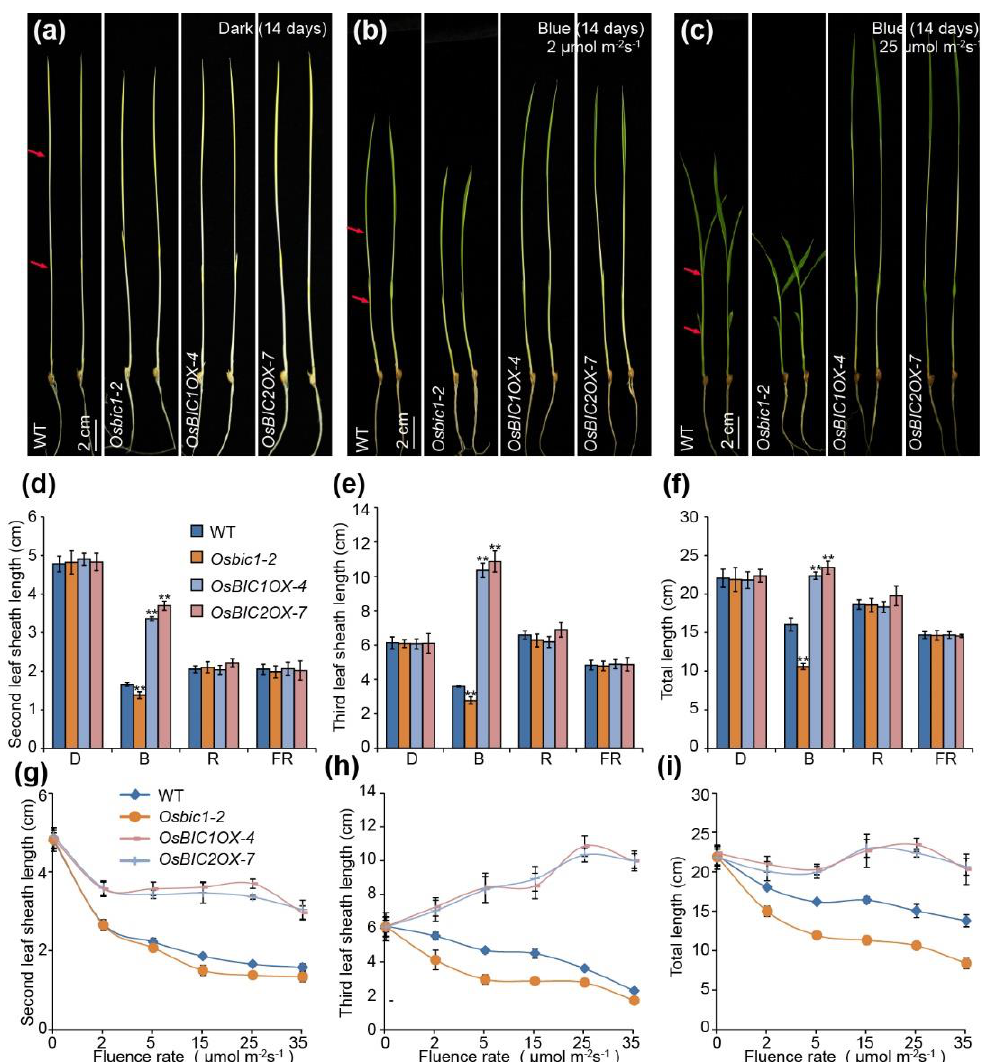
Figure 1. OsBICs (OsBIC1 and OsBIC2) promoted leaf sheath growth under blue light conditions. ( a – c ) Representative seedlings image of WT, Osbic1-2 mutant, and OsBICs overexpression lines ( OsBIC1OX-4 and OsBIC2OX-7 ) grown under continuous dark ( a ), 2 µmol m −2 s −1 blue light ( b ), and 25 µmol m −2 s −1 blue light ( c ) conditions at 28 °C for 14 days. The red arrow represented the measured position of the second leaf sheath and the third leaf sheath. Scale bars = 2 cm. ( d – f ) The statistics results of second leaf sheath length ( d ), third leaf sheath length ( e ), and total length ( f ) of 14 days old seedlings grown under continuous dark, blue light (25 µmol m −2 s −1 ), red light (25 µmol m −2 s −1 ), or far-red light (15 µmol m −2 s −1 ) conditions. Mean values ± s.d. ( n = 20) are shown. Comparisons were performed by Student’s t- tests (** p < 0.01). ( g – i ) The statistics results of second leaf sheath length ( g ), third leaf sheath length ( h ), and total length ( i ) of 14 days old seedlings grown under continuous blue light with an intensity of 0 to 35 µmol m −2 s −1 . Kita-ake wild-type plants (WT) were used as control.